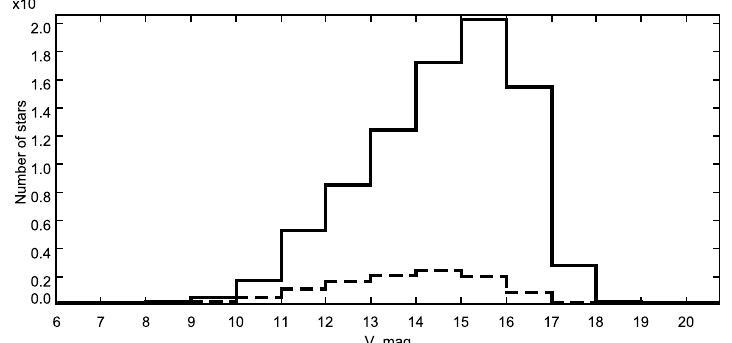
Fig. 7. Distribution of simulated systems over brightness: all systems (solid line) and systems with eclipses (dashed line).